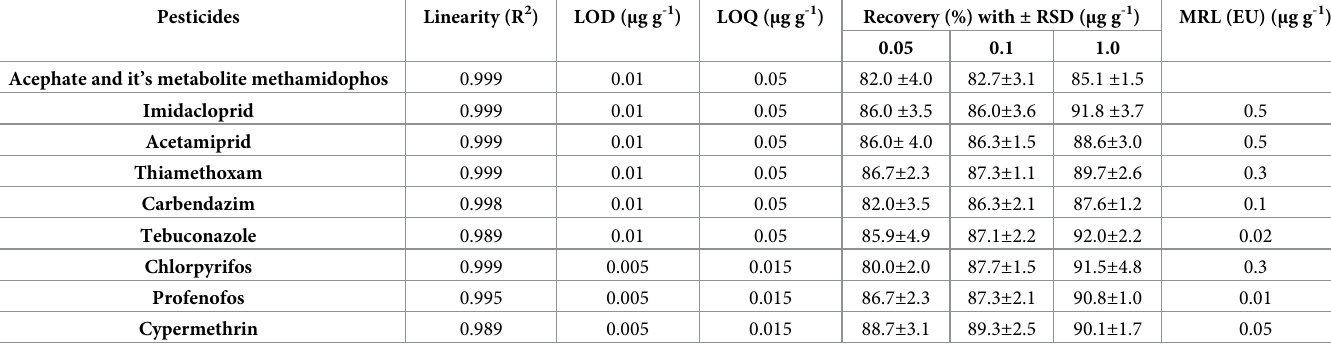
Table 3. Method validation data and MRLs of pesticides in okra.